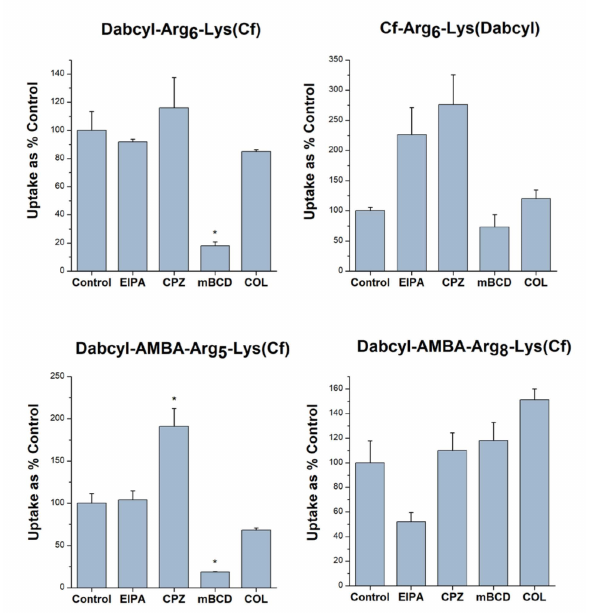
Figure 5. The role of different endocytic routes in the cellular uptake of peptides. EBC-1 cells were pretreated with the inhibitors EIPA (50 µ M), CPZ (30 µ M), mBCD (5 mM) and COL (20 mM) for 30 min, then the cells were treated with the peptide conjugates (5 µ M) for 90 min. Any significant difference from the control was measured using the Student’s t test (* p <